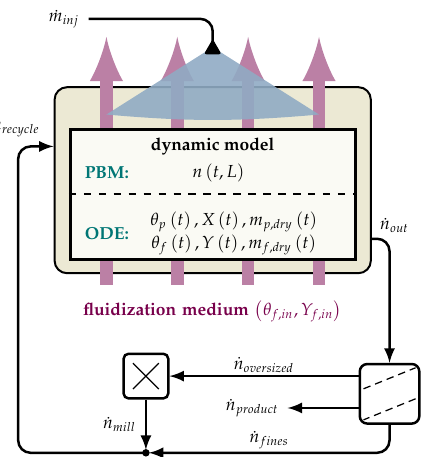
Figure 3. Flow sheet of fluidized bed layering granulation (FBLG). (PBM: population balance model; ODE: ordinary differential